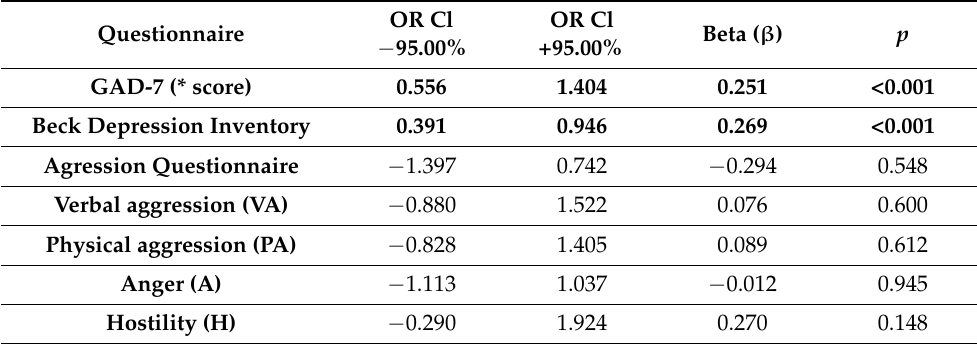
Table 3. Multivariate linear regression based on the Internet Use Test.